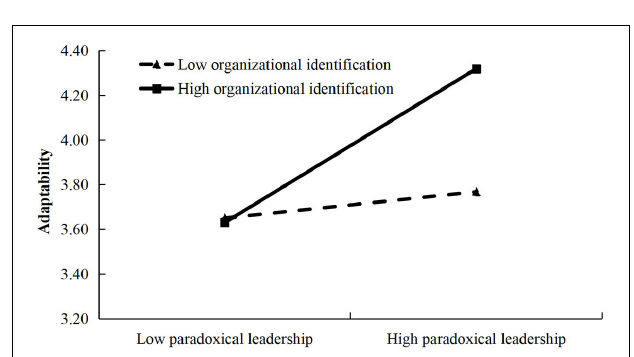
FIGURE 2 | Interaction effect of paradoxical leadership and Zhong Yong thinking.